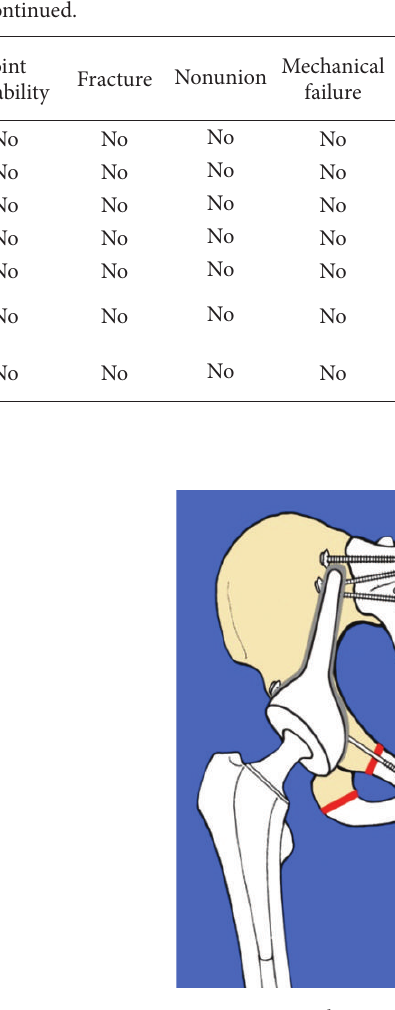
Figure 5: Reconstruction with CISP (P1-P2